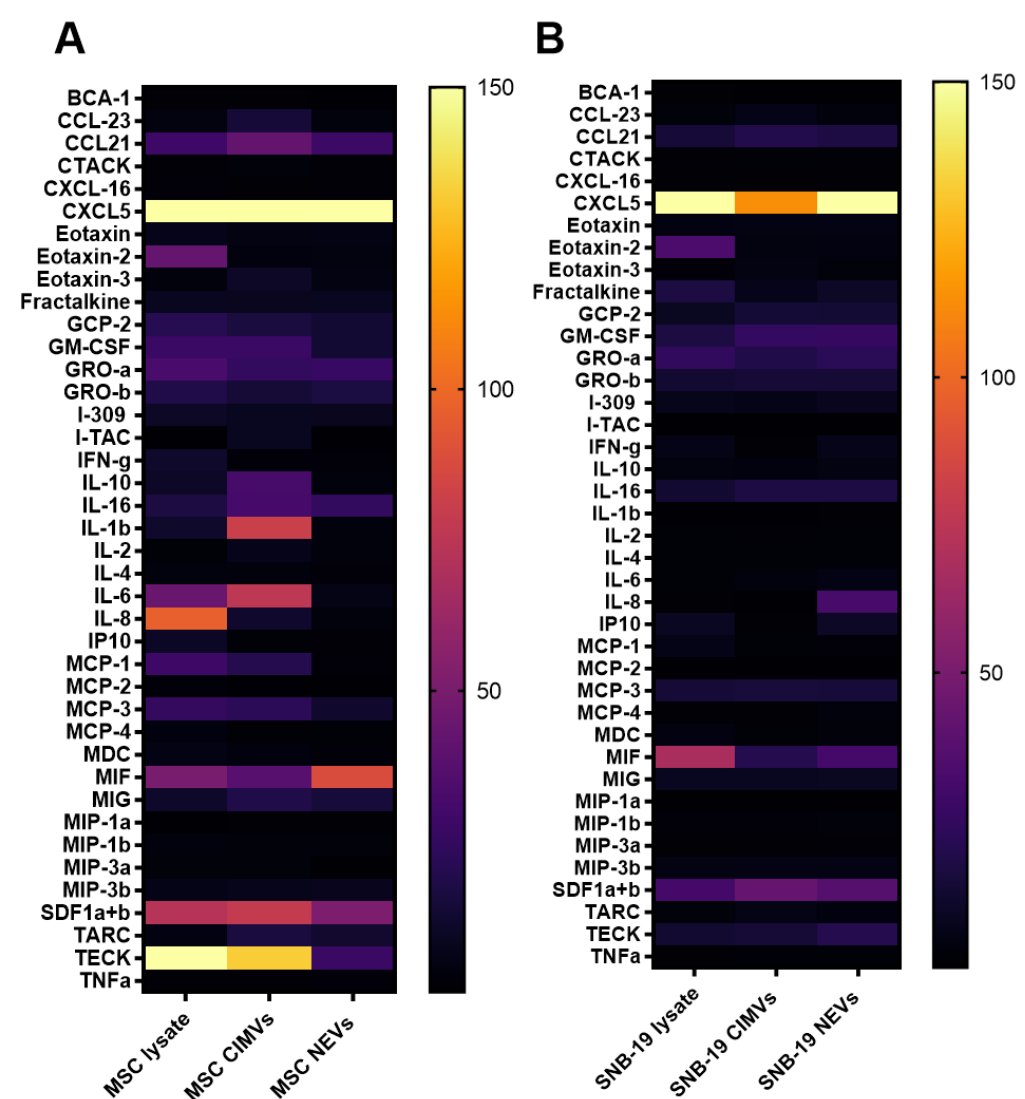
Figure 5. Heatmap of cytokine/chemokine concentrations in the cell and extracellular vesicle lysate. ( A ) Samples of MSCs. ( B ) Samples of SNB-19. All the samples were normalized relative to the total protein concentration. Data are shown as the mean ± SD ( n = 6) of two biological replicates.